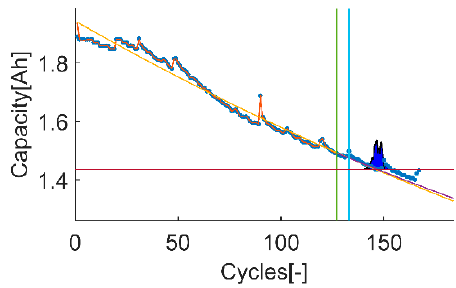
Figure 17. Time-instant figure of test 1 on t 118 .